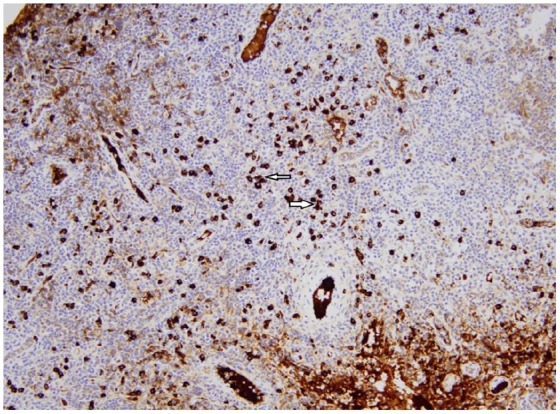
Low-power field (20×) showing abundant IgG4 plasma cells on IgG4 staining.
Arrows pointing to IgG4-positive plasma cells.